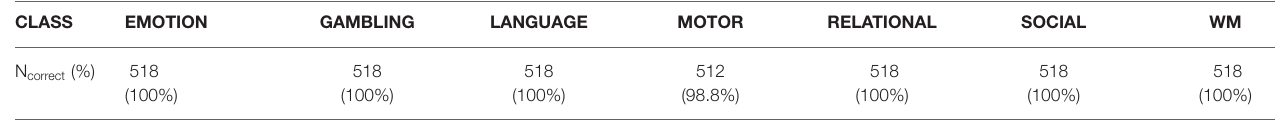
TABLE 1 | Decision profile of DNN classifier on counterfactual activations.